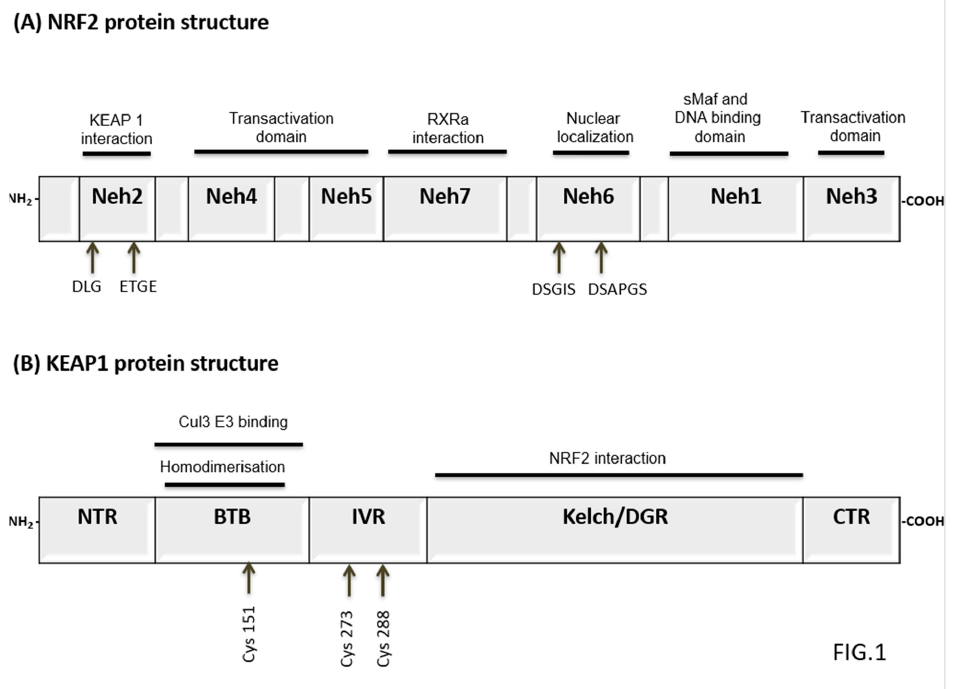
Figure 1. Domain architectures of Kelch-like ECH-associated protein 1 (KEAP1) and nuclear factor erythroid 2-related factor 2 (NRF2). ( A ) Human NRF2 protein is 605 amino acids long and contains